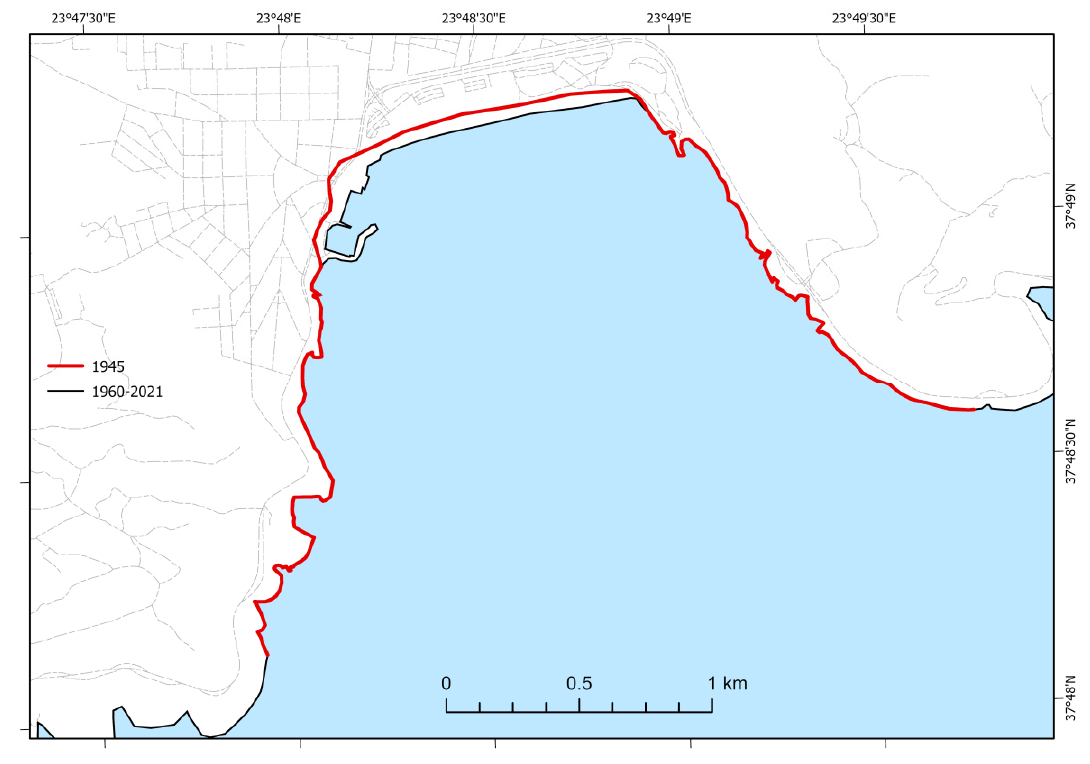
Figure 9. The coastlines of Vari Bay from 1945 to 2021.